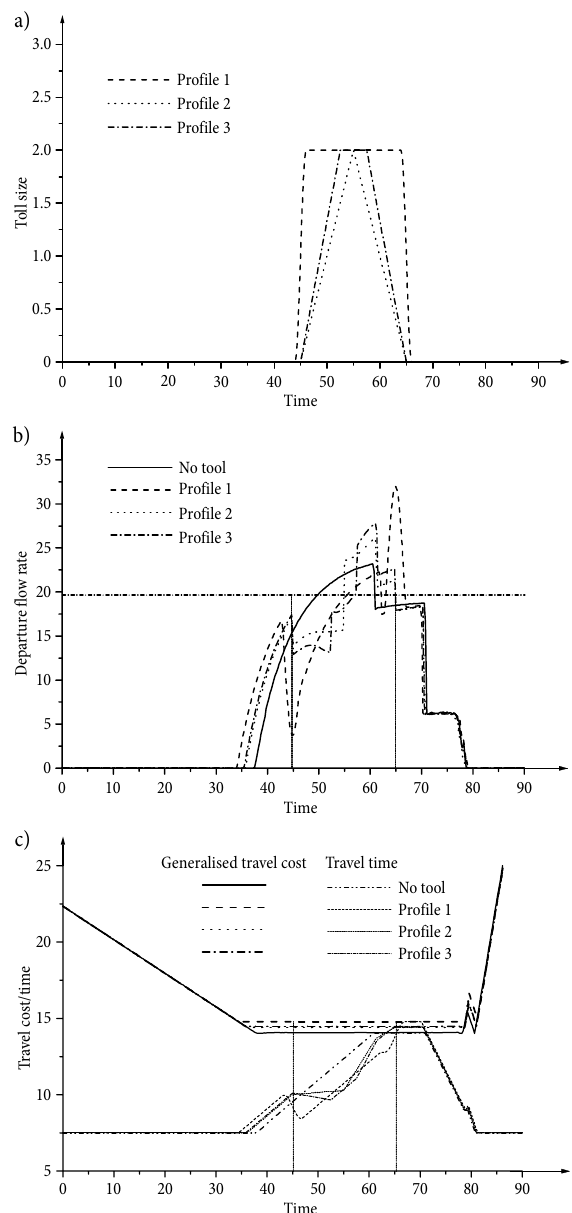
Fig. 5. Solution profiles for charging period choice: a – toll profiles; b – departure travel times; c – travel times and